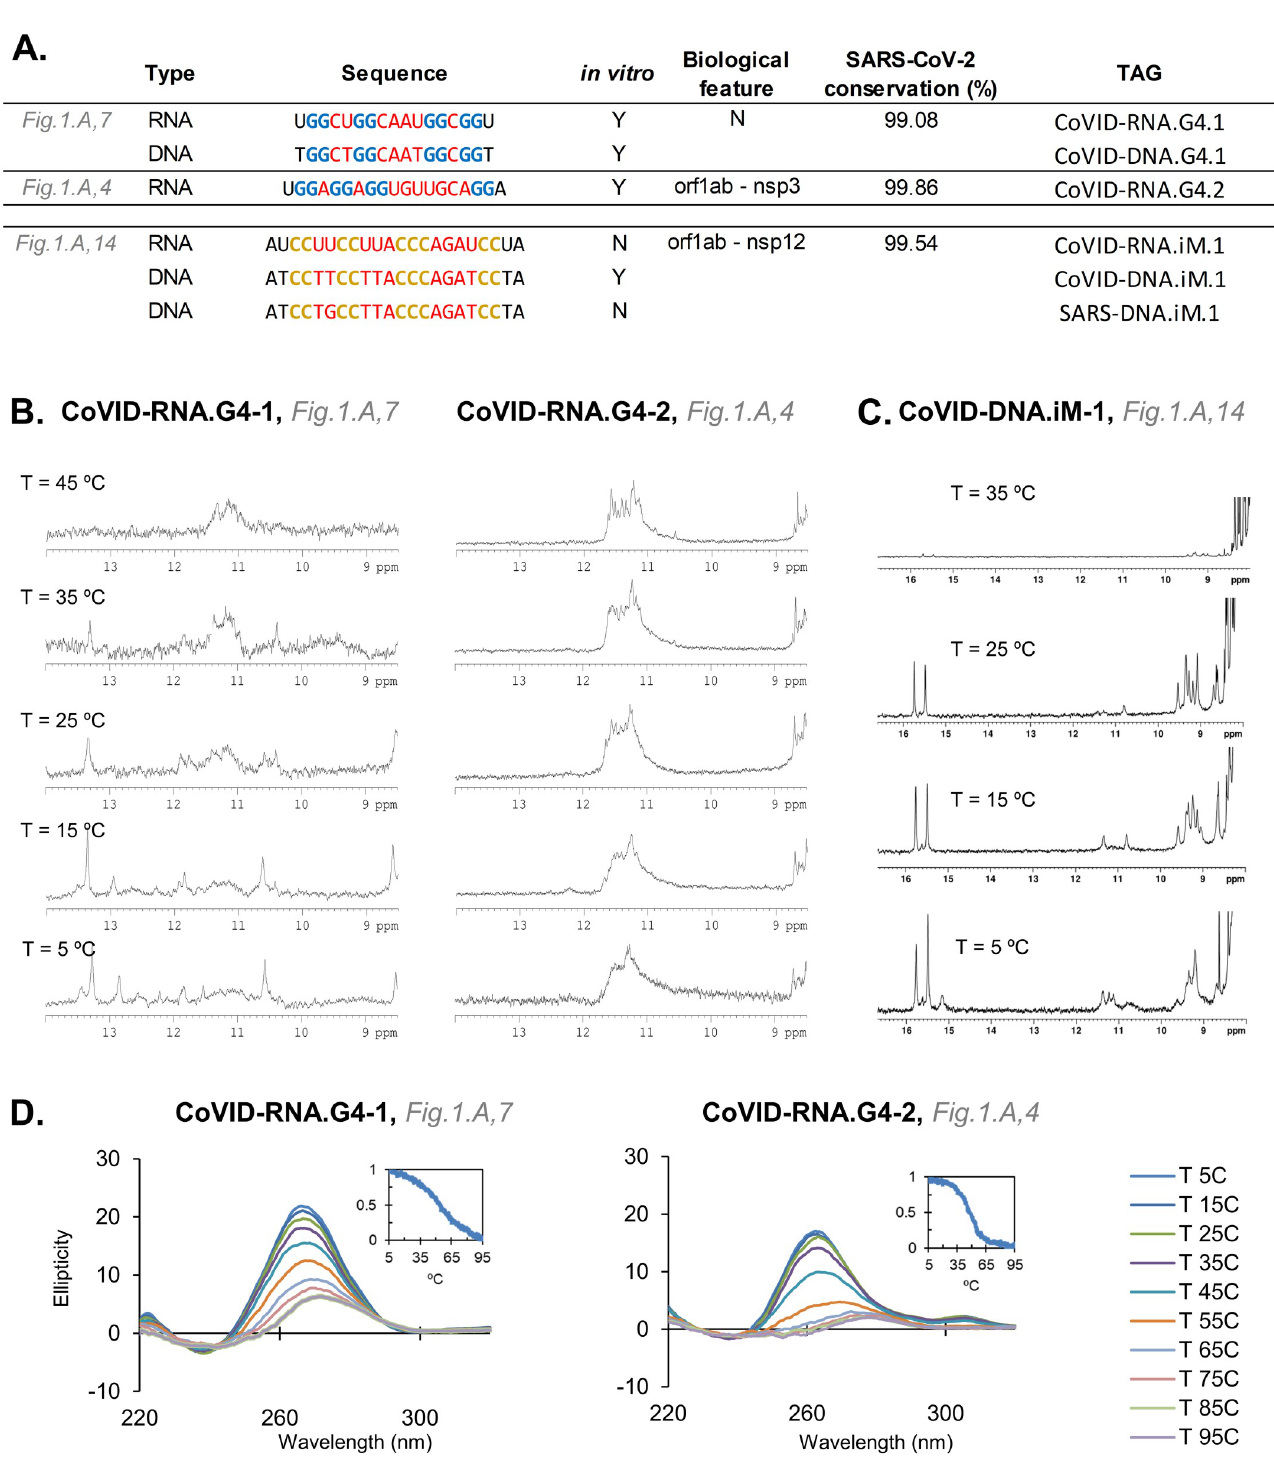
Fig 4. A . The candidates examined in vitro through biophysical assays. The in vitro column states if the sequence forms a quadruplex (Y for Yes, N for No). B , NMR spectra of the two RNA-G4s analyzed at different temperatures (pH 7.0). C , NMR spectra of the DNA-iM analyzed at different temperatures (pH 5.3). D , CD analysis of the two RNA-G4